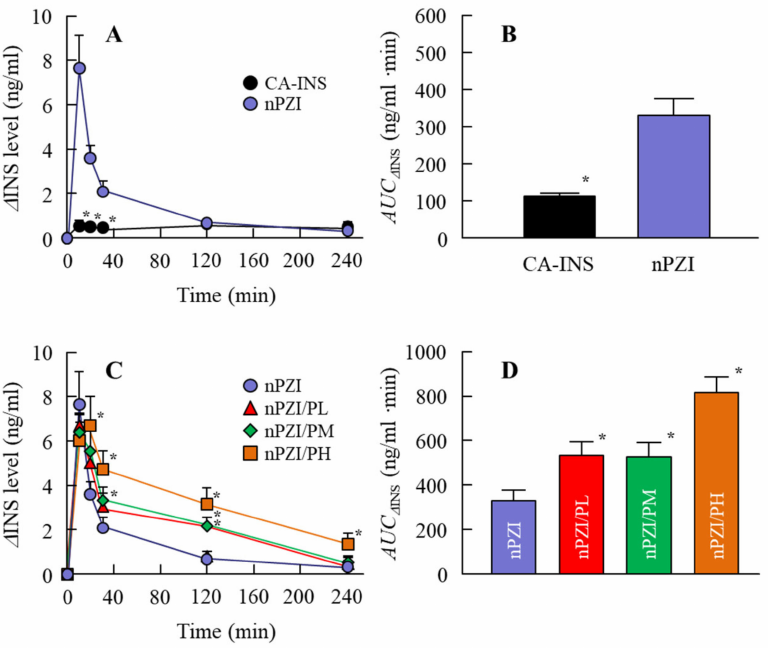
Figure 4. Changes in plasma INS ( A , C ) and AUC ∆ INS ( B , D ) levels in normal rabbits instilled with CA- INS, nPZI, nPZI/PL, nPZI/PM, or nPZI/PH. The compositions of the INS ophthalmic formulations are shown in Table 1. n = 6–8. * p < 0.05 vs. nPZI for each category. The ∆ INS levels in rabbits instilled with nPZI were significantly higher than in rabbits instilled with CA-INS, and the ∆ INS levels were enhanced by the addition of PAA in